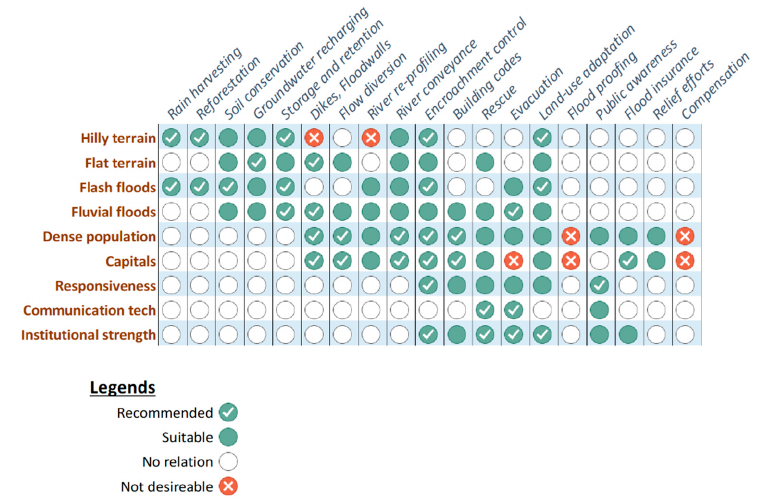
Figure 4. A practical example of flood management option priorities about di ff erent characteristics of the